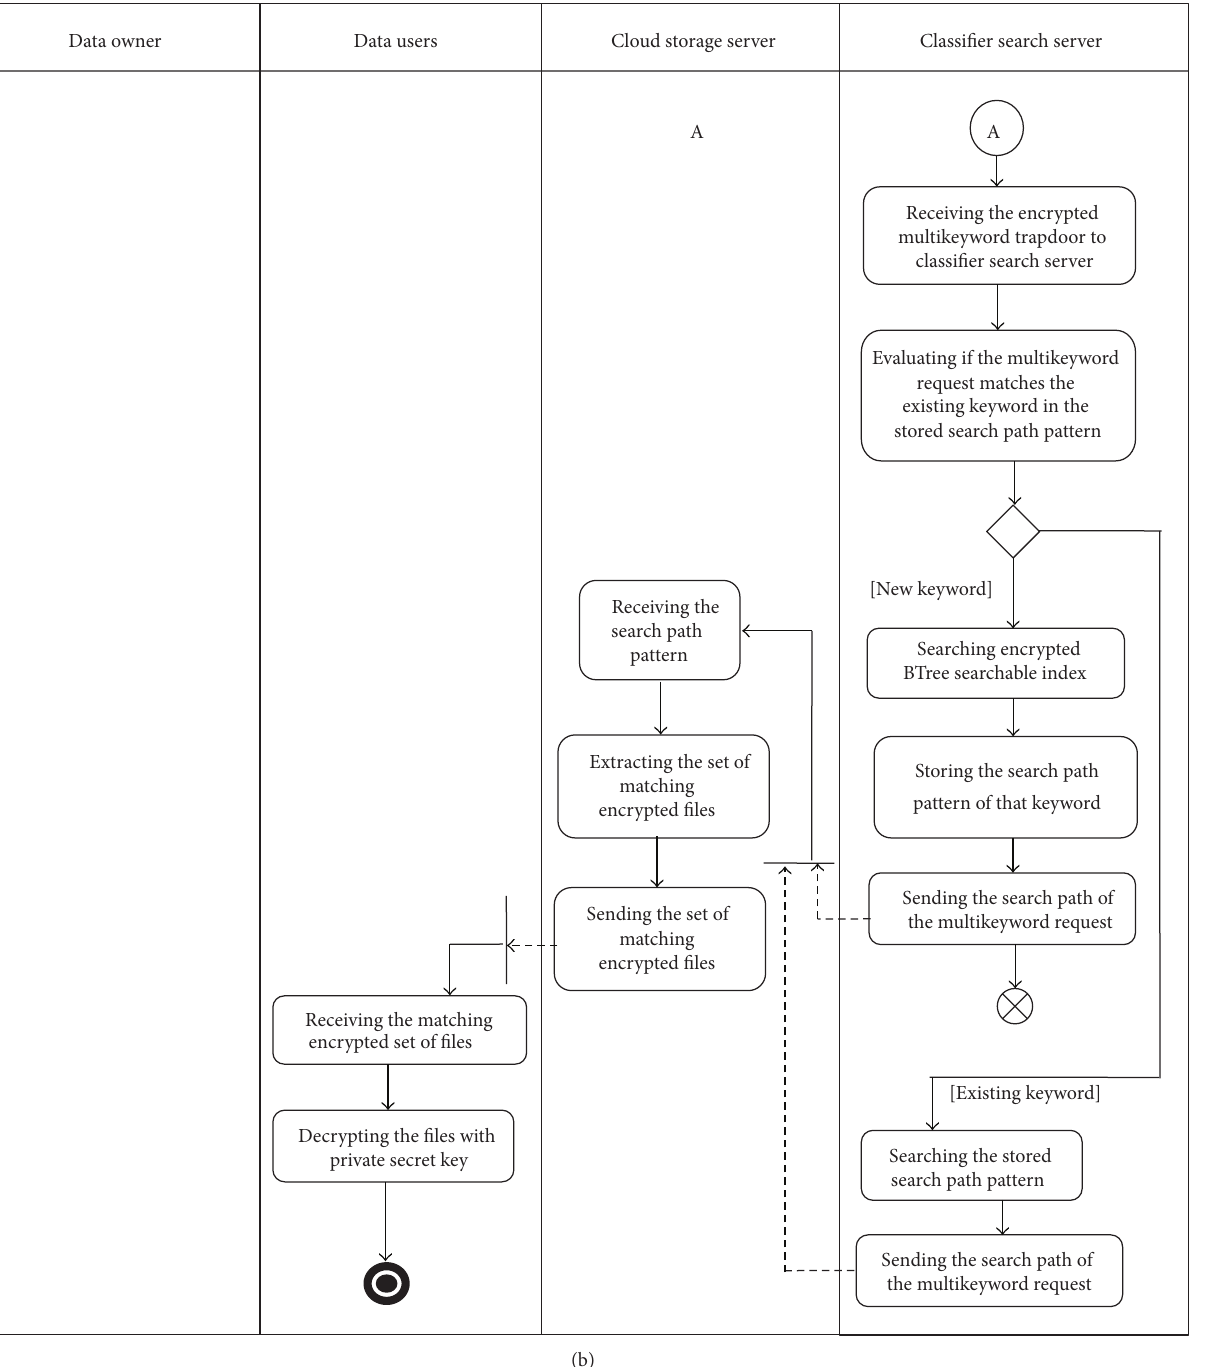
Figure 2: Activity diagram for Asymmetric Classifier Multikeyword Fuzzy